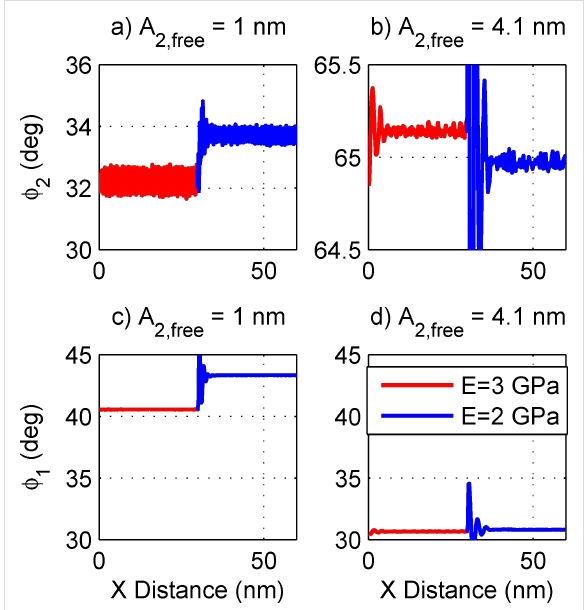
Figure 4: Simulated line scans for the parameters in Table 2 and two different second eigenmode drive amplitudes. The simulated sample is a PE domain in the center of a PP matrix. Comparing (a) versus (b), there is a clear contrast reversal of between the low and high second eigenmode drive. This matches the experimental observations of Figure 2. Further, comparing (c) versus (d), drops as A 2,init is raised. This matches the experimental observation in Figure 3.